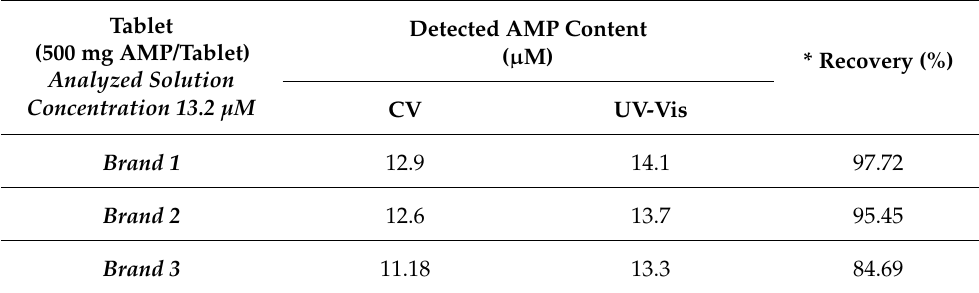
Table 3. Summary of the detected acetaminophen contents of different commercially available tablet